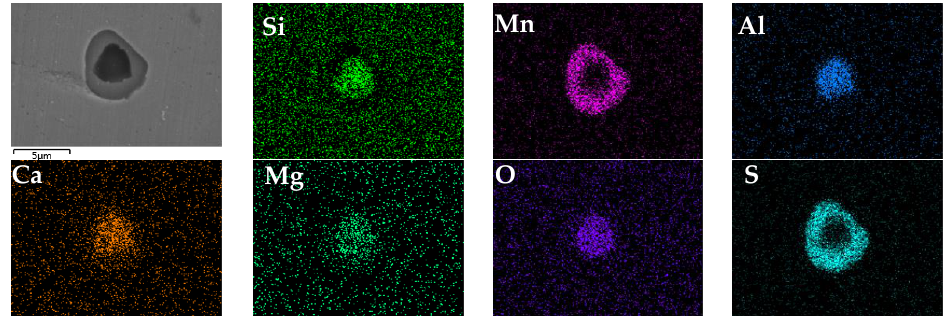
Figure 14. SEM mapping of typical inclusions in steel treated with synthetic refining slag containing Na 2 O. Metals 2018 , 8 , x FOR PEER REVIEW